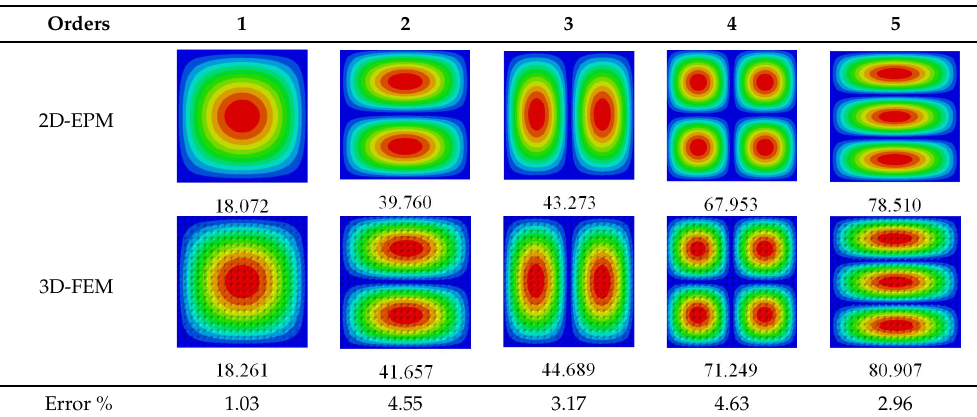
Table 3. Comparison of natural frequencies (Hz) and mode shapes of CCCP in Case 3 predicted by different